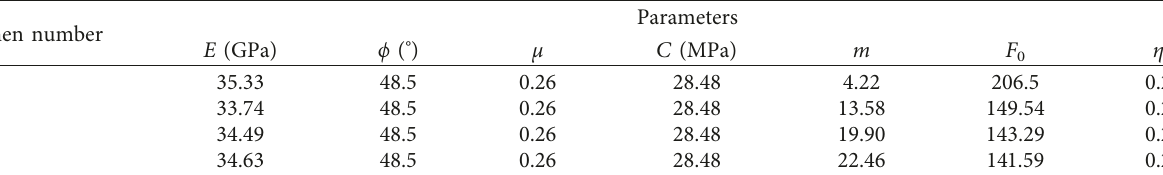
Table 3: Experimental parameters and fitting parameters.